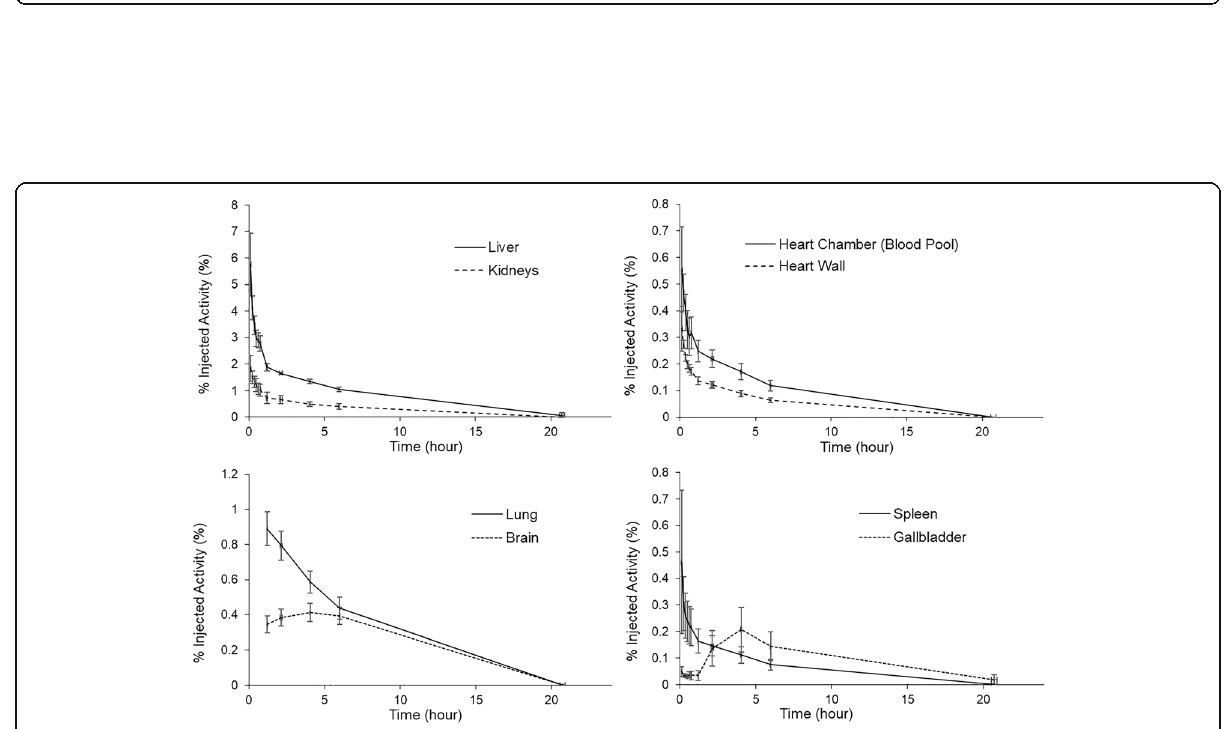
Fig. 4 Time-activity curves in representative organs. [ 18 F]DiFA was rapidly cleared from the organs. The accumulation in the gallbladder peaked after 4 h, since [ 18 F]DiFA that was excreted in the bile due to hepatobiliary excretion stayed in the gallbladder and was secreted with a meal (at 4 h after examination). The accumulation in the brain slowly increased, reflecting the improvement in water solubility, and after 4 h, it peaked and then decreased. The data are the mean ± SD of results from six